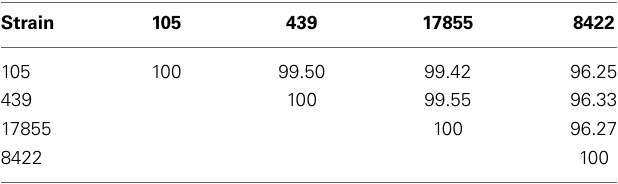
Table 1 | Percent two-way average nucleotide identities (ANI) at the whole genome level between the B. dorei 105 and 439 genomes described here and the nearly complete genome of B. dorei DSM 17855 and the complete genome of B. vulgatus ATCC 8482.